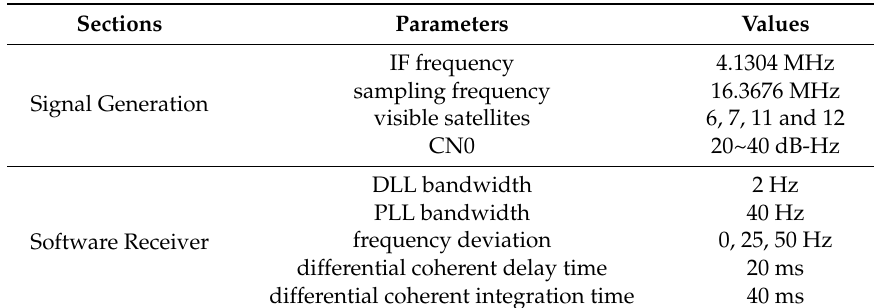
Figure 7. The diagram of the platform for Monte Carlo simulations. Table 2. Parameters used in the Monte Carlo simulations.